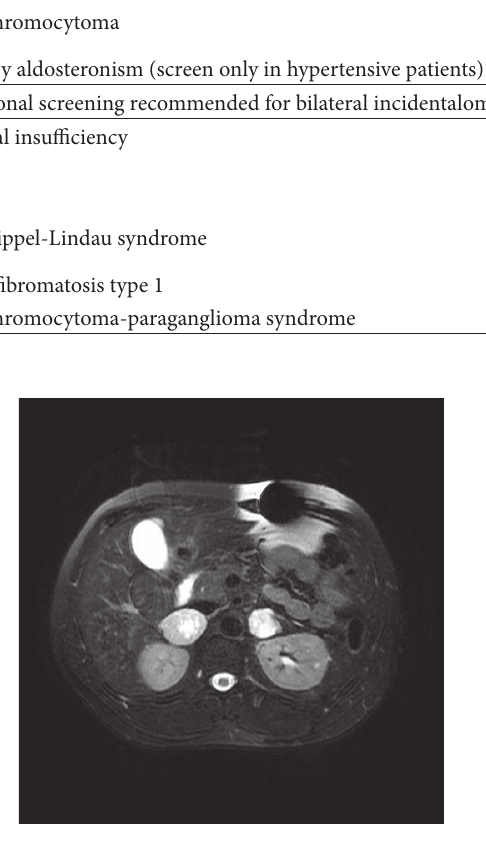
F 1: T2-weighted MRI of the abdomen showing bilateral adrenal masses. e le mass measures 4.3cm and the right mass measures 2.8cm in greatest